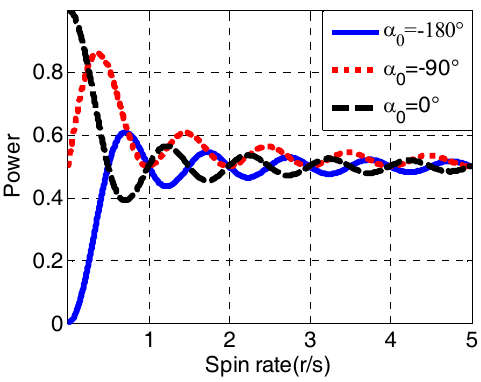
Figure 6. The diagram of normalized average power in one second.